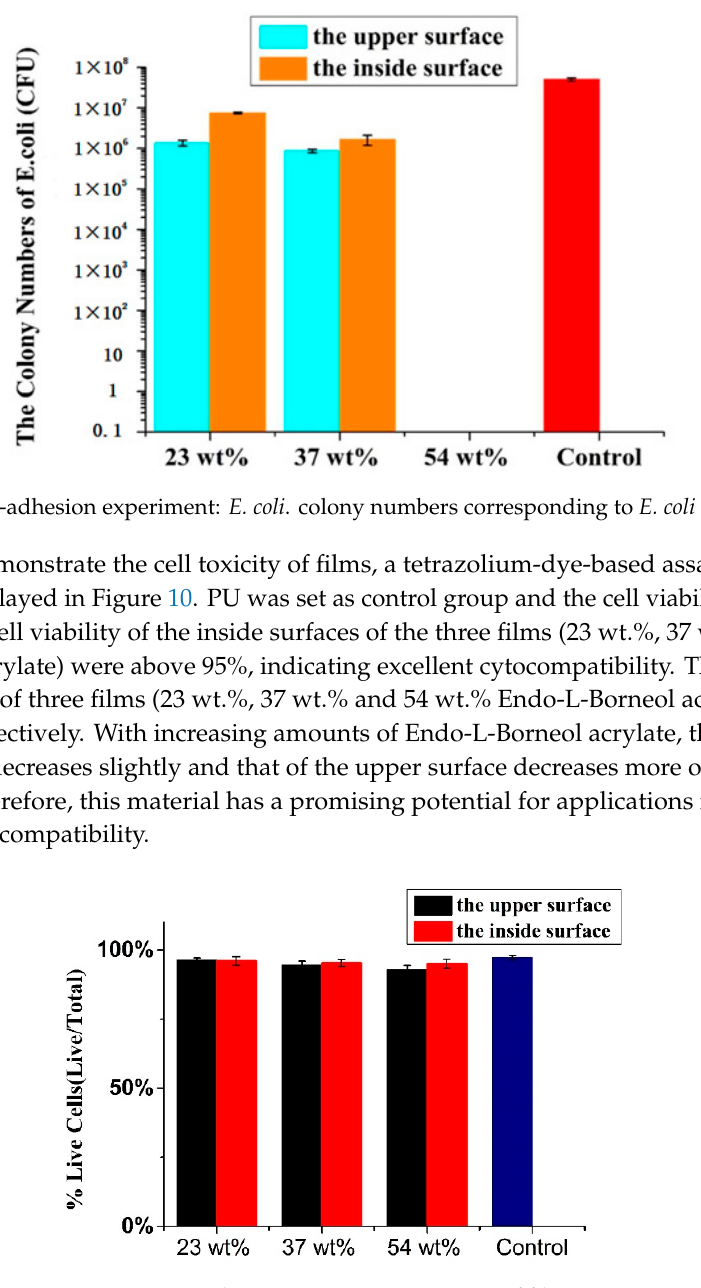
Figure 10. The in-vitro cytotoxicity tests of films.